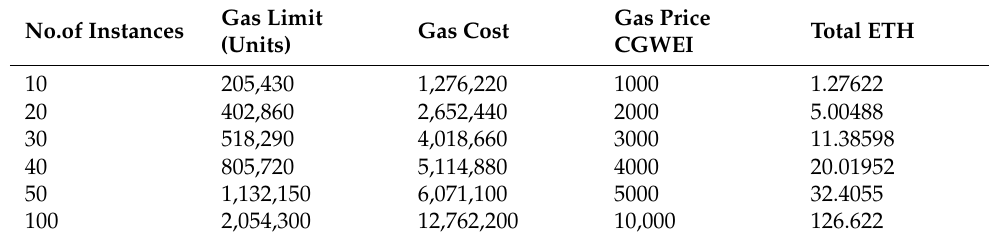
Table 5. Instances Gas costs.